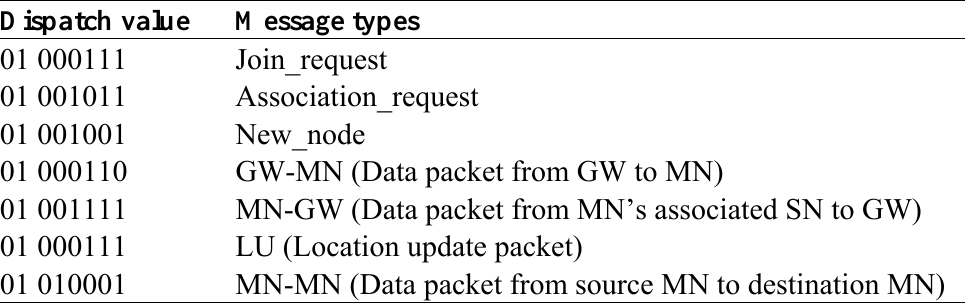
Table 1. Dispatch values for the